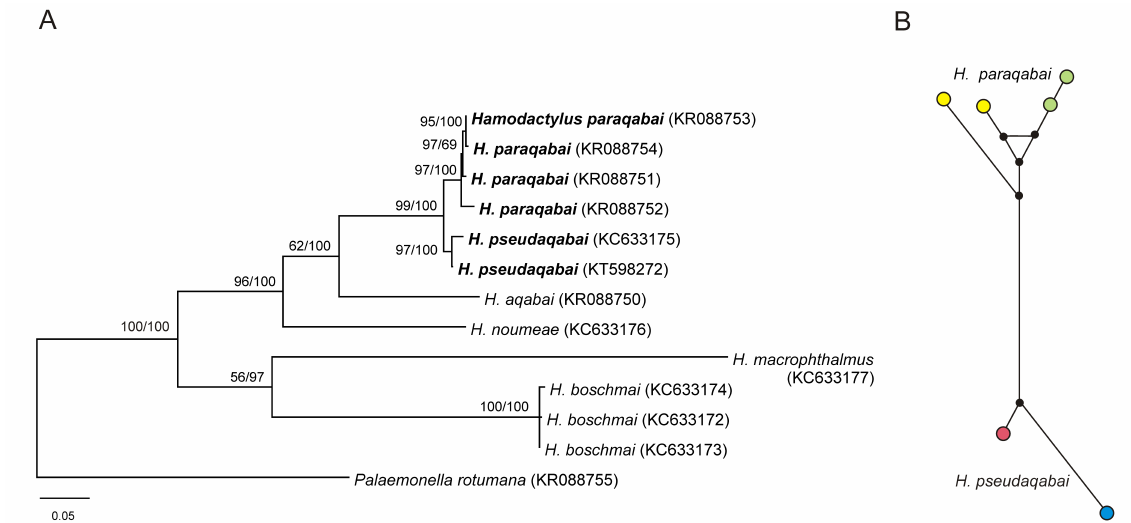
Fig. 11. Results of molecular analyses of Hamodactylus spp. A . Phylogenetic tree resolved by Maximum Likelihood based on COI sequence data with the HKY+I+G substitution model (bootstrap values are expressed as percentages in the order ML/BI; GenBank accession numbers are provided for all specimens; newly described species are in bold). B . Median-joining haplotype network showing phylogenetic relationships among haplotypes of the COI gene of two new species of Hamodactylus (yellow colour denotes haplotypes sampled in Madang Lagoon, Papua New Guinea; green in Lizard Island, Australia; blue in Sabah, Malaysia; red in Sulawesi, Indonesia); small black circles represent missing (hypothesised) haplotypes to connect existing sequences within the network with maximum